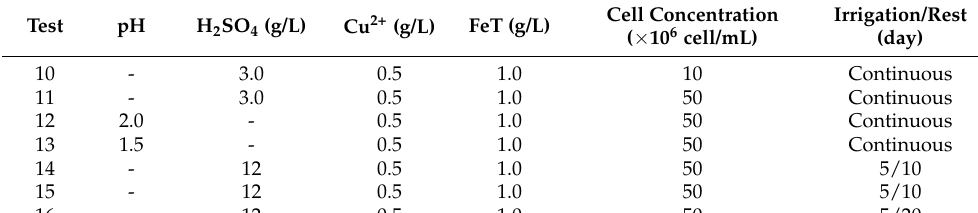
Table 4. List of tests performed on the chalcopyrite ore using columns 1.0 m in height.